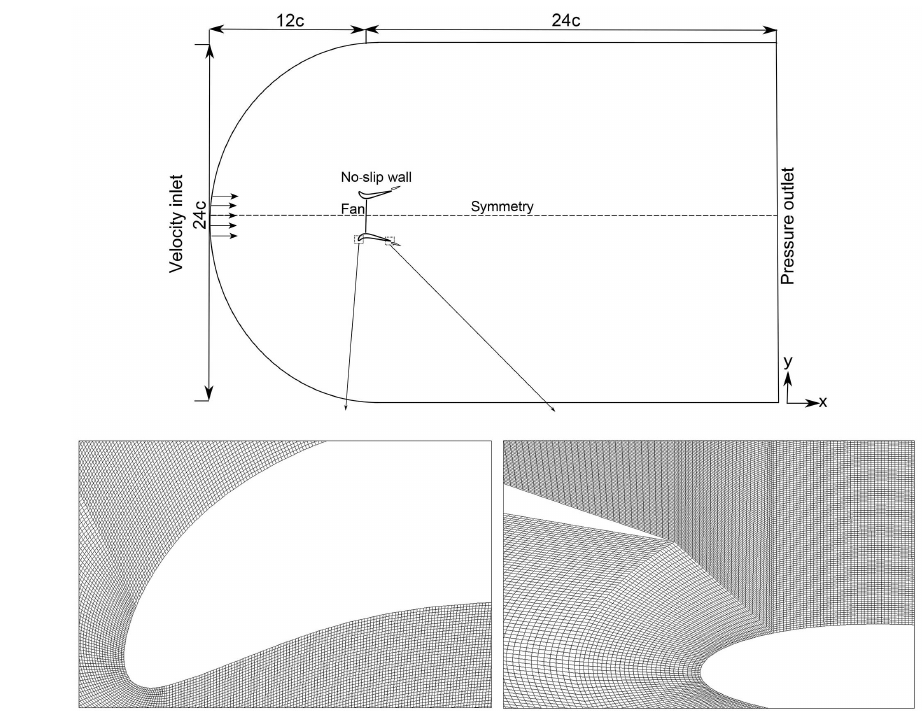
Figure 6. Computational domain showing the boundary conditions employed. The length is indicated in terms of duct chord length c (representative, not to scale). The computational grid along the duct and flap leading edge is zoomed in to show the C-grid and boundary layer refinement.